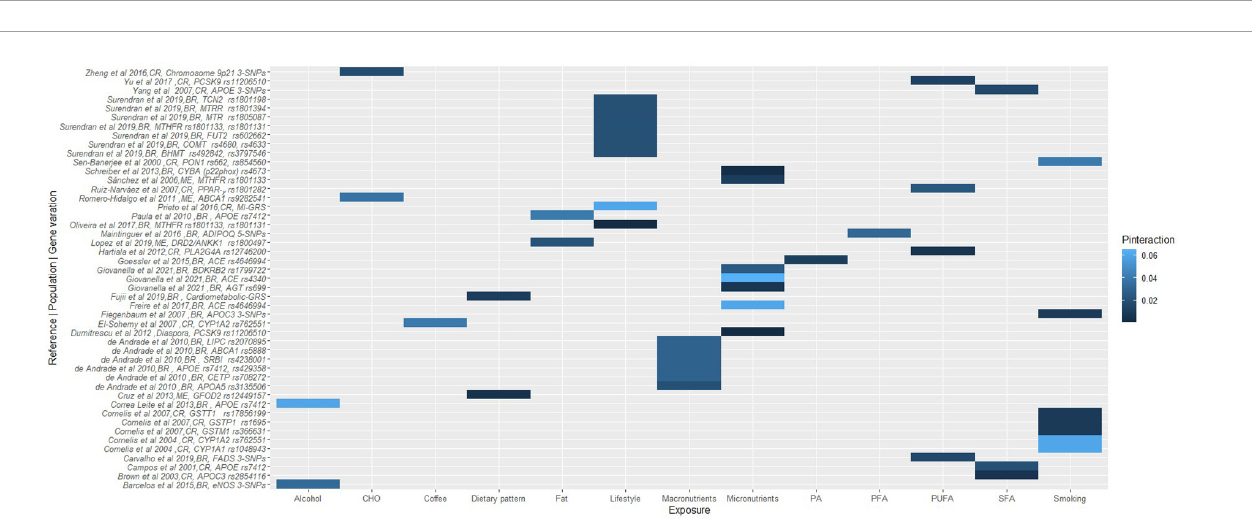
FIGURE2 A heat map showing the findings for gene-lifestyle interactions on cardiovascular disease traits. Sotos-Prieto et al. (144), MI-GRS = CDKN2A/2B (rs4977574, rs10757274, rs2383206, rs1333049); CELSR2-PSRC1-SORT1 (rs646776, rs599839); CXCL12(rs501120, rs1746048); HNF1A, C12orf43 (rs2259816); MRAS (rs9818870); SLC22A3 (rs2048327); LPAL2 (rs3127599); LPA (rs7767084, rs10755578); Fujii et al. (64), Cardiometabolic-GRS = APOA5 (rs662799); APOB (rs693, rs1367117); LDLR (rs688, rs5925); LIPC (rs2070895, rs1800588); Brown et al. (125), 3-SNPs = APOE rs7412, rs449647, rs429358 ; Fiegenbaum et al. (92), 3-SNPs = APOC3 rs2854116, rs2854117, rs5128; Maintinguer Norde et al. (75), 5-SNPs = ADIPOQ rs2241766, rs16861209, rs17300539, rs266729, rs1501299; Carvalho et al. (65), 3-SNPs = FADS rs174575, rs174561, rs3834458; Barcelos et al. (88), 3-SNPs = eNOS rs2070744, rs1799983, rs61722009; Zheng et al. (135), 3-SNPs = Chromosome 9p21 rs4977574, rs2383206, rs1333049. BR, Brazilian; CR, Costa